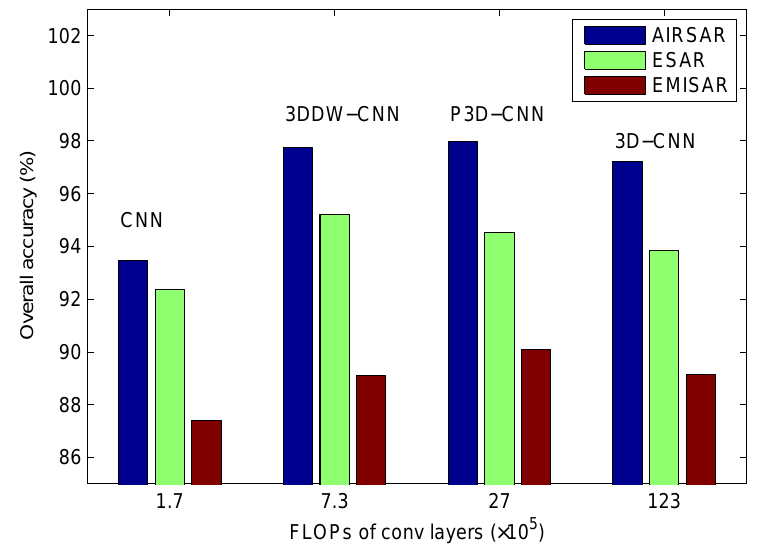
Figure 15. Comparisons of accuracy and